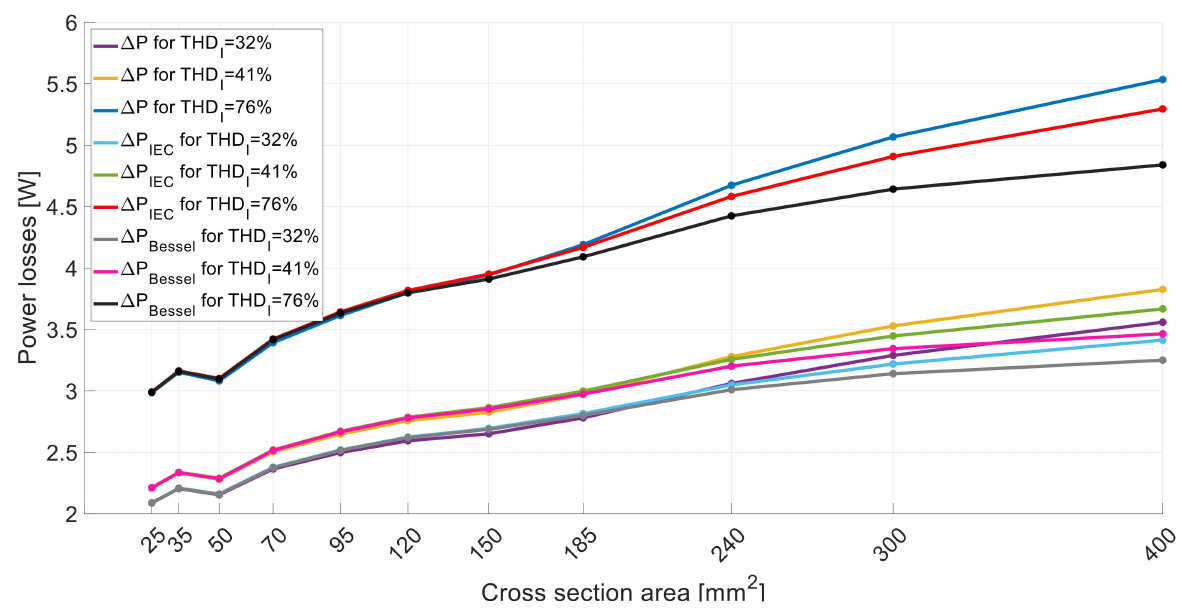
Figure 7. The comparison of both skin effect calculation methods for I = 0.25 I dd . The differences between the analyzed methods are dependent on the cable cross- section area. For cables, the 25, 35, 50, 70 mm 2 obtained results for the unitary power losses are very similar. The differences are maximally equal to 0.1 W—the skin effect is limited due to the small cable radius. If the CPD is smaller than the cable radius, the effective resistance for each harmonic increases. It is easier to understand power losses dependence for small cross-sections. The presented methods gave more divergent values for cross-sections higher than 185 mm 2